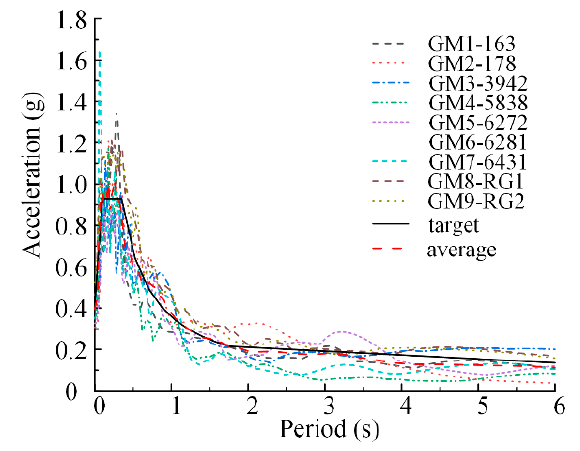
Figure 15. Seismic wave response spectrum.